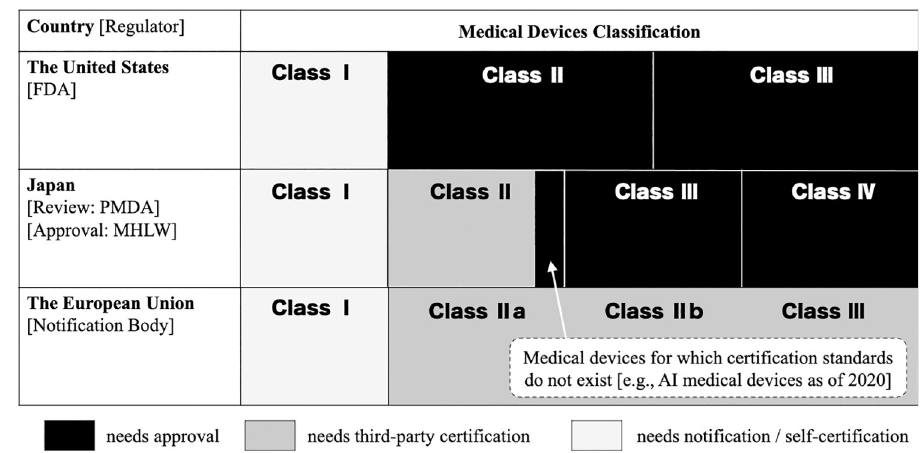
Fig 2. Comparison of the regulation for marketing approval of medical devices among the United States, Japan, and European Union. The figure illustrates the regulatory status of the three nationalities based on the classification of medical devices. In Japan, medical devices of class III or more and those of class II for which certification standards do not exist (e.g., artificial intelligence (AI) medical devices as of 2020) require the review of Pharmaceuticals and Medical Devices Agency as well as the approval of the Ministry of Health, Labour, and Welfare. A software that corresponds to class I medical device is not treated as medical device in Japan. FDA: Food and Drug Administration; PMDA: Japanese Pharmaceuticals and Medical Devices Agency; MHLW: Ministry of Health, Labour, and Welfare.